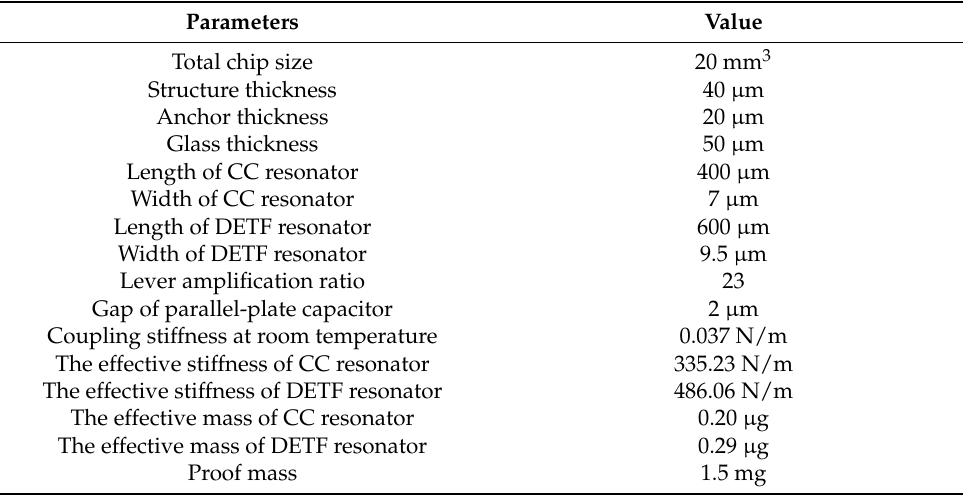
Figure 4. Simulation model of DETF-CC WCR mode-localized accelerometer with DETF-CC resonators ( a ) and left view ( b ). Table 1. Structure dimensions of the mode-localized accelerometer.